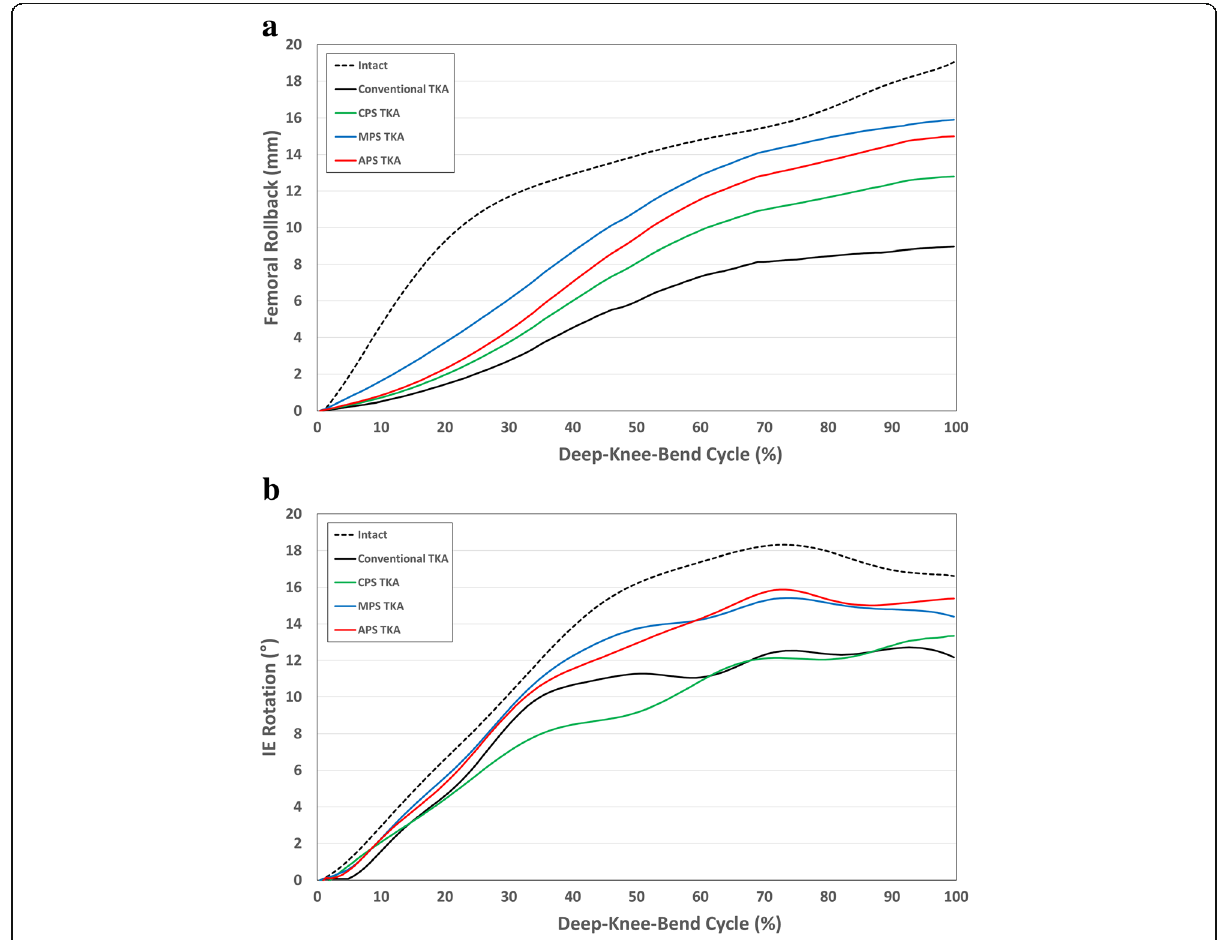
Fig. 5 Comparison of a femoral rollback and b IE kinematics between conventional TKA and three different conformity of patient-specific TKA during deep-knee-bend